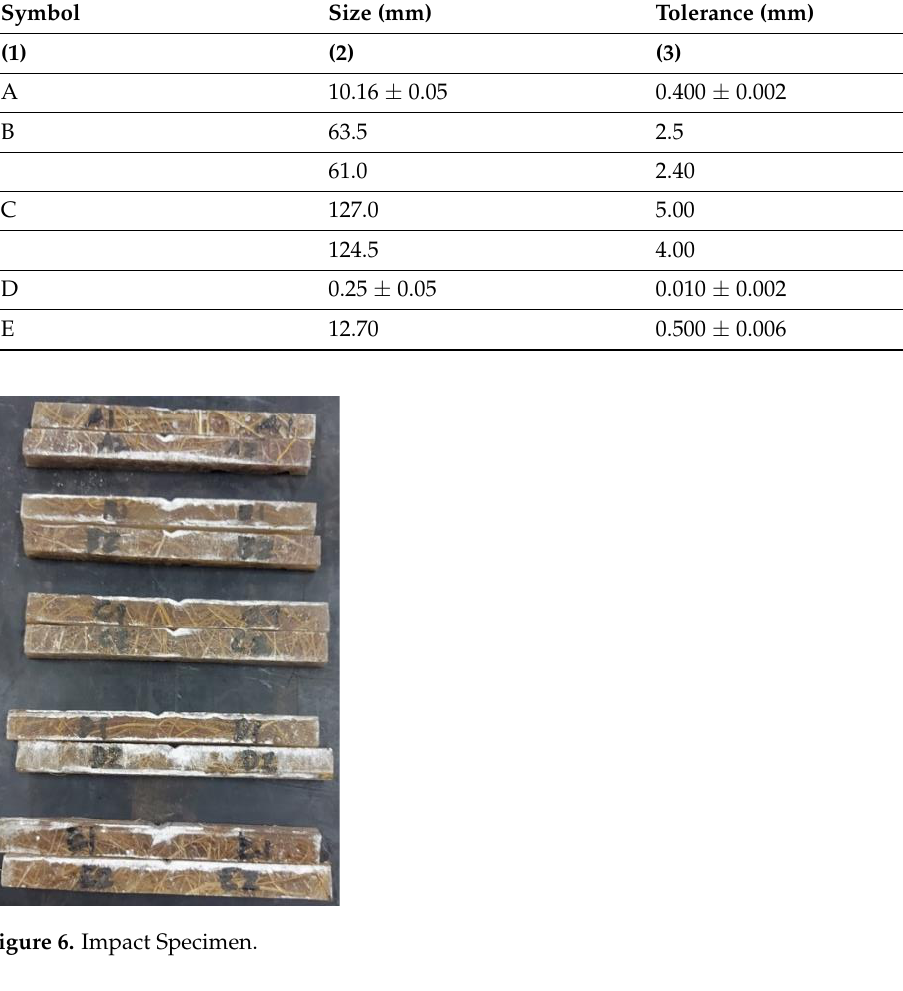
Figure 6. Impact Specimen. Figure 7. Impact testing process. Figure 7. Impact testing process.